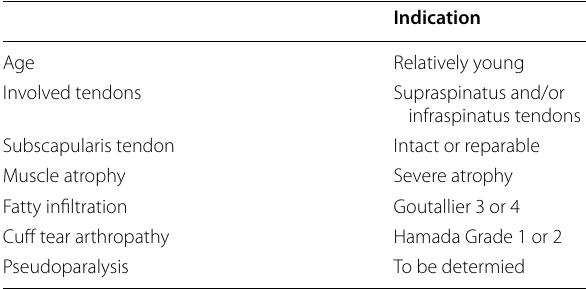
Table 1 Indication of the superior capsular reconstruction